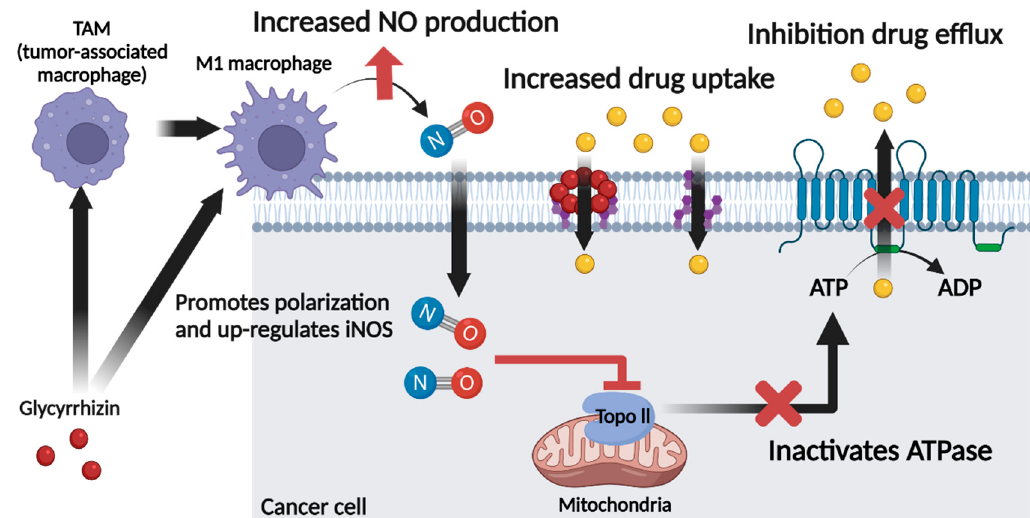
Figure 7. Mechanisms by which GL acts as an NO regulator and MDR inhibitor. Image created with BioRender icons. GL induces polarization of TAMs to the M1 phenotype and upregulates iNOS expression, resulting in increased NO production; GL also inhibits MDR directly through increased drug uptake and inactivation of ATPase.